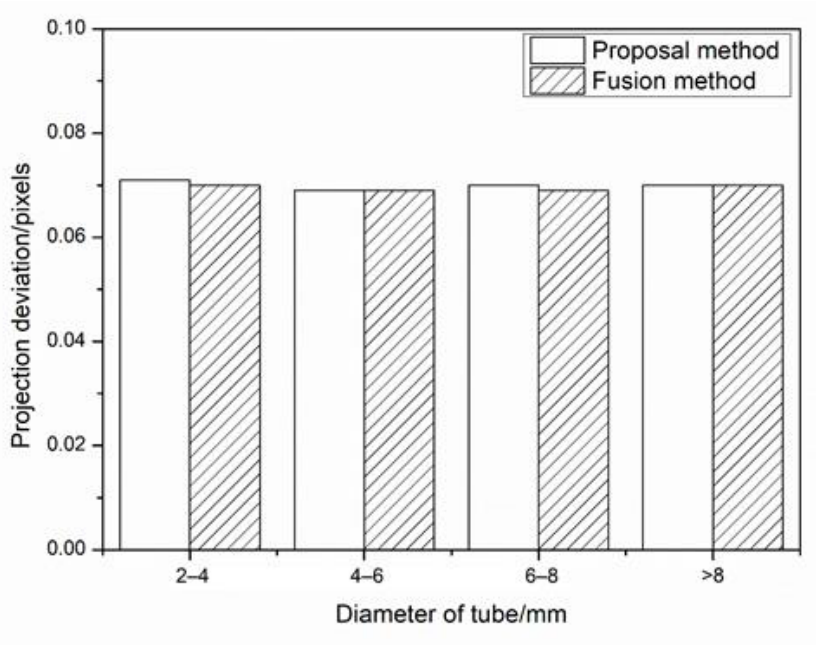
Figure 12. Projection deviation of the reconstruction results.